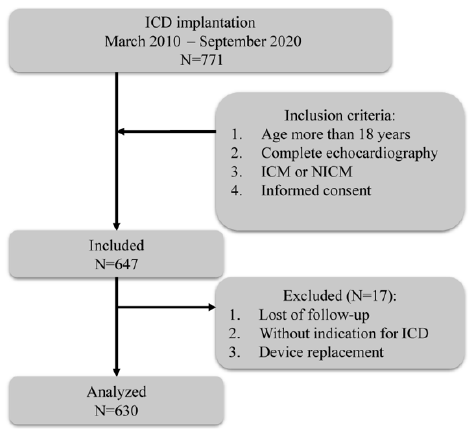
Figure 1. Flowchart of the study. ICD, implantable cardioverter defibrillation; ICM, ischemic cardiomyopathy; NICM, non-ischemic cardiomyopathy.